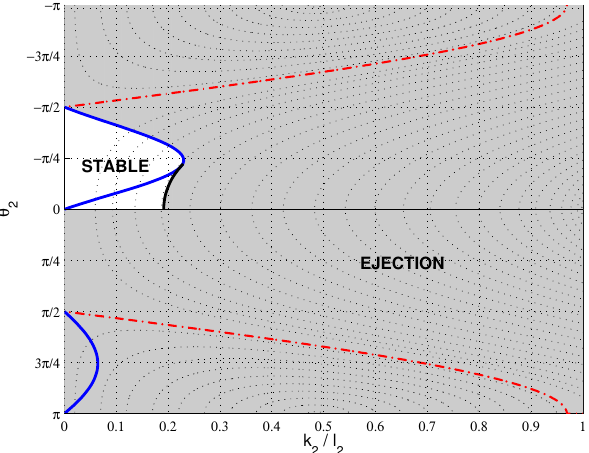
Figure 7. Final grasp-state plane of Da Vinci’s finger.